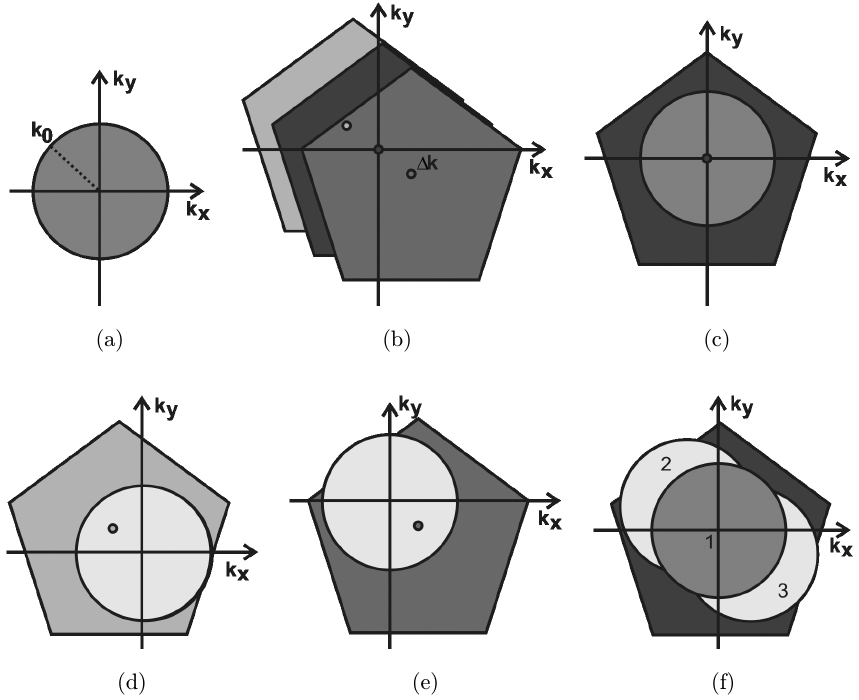
Fig. 1. Schematic of frequency spectrum expansion by structured illumination. (a) The OTF of common °uorescence microscopy, (b) is superposition of three frequency spectra components by structured illumination, (c) – (e) are three components of frequency spectra, multiplying the OTF, separating from each other, moving to the corresponding place, respectively, (f) addition of the three components of frequency spectra, having been moved to the corresponding